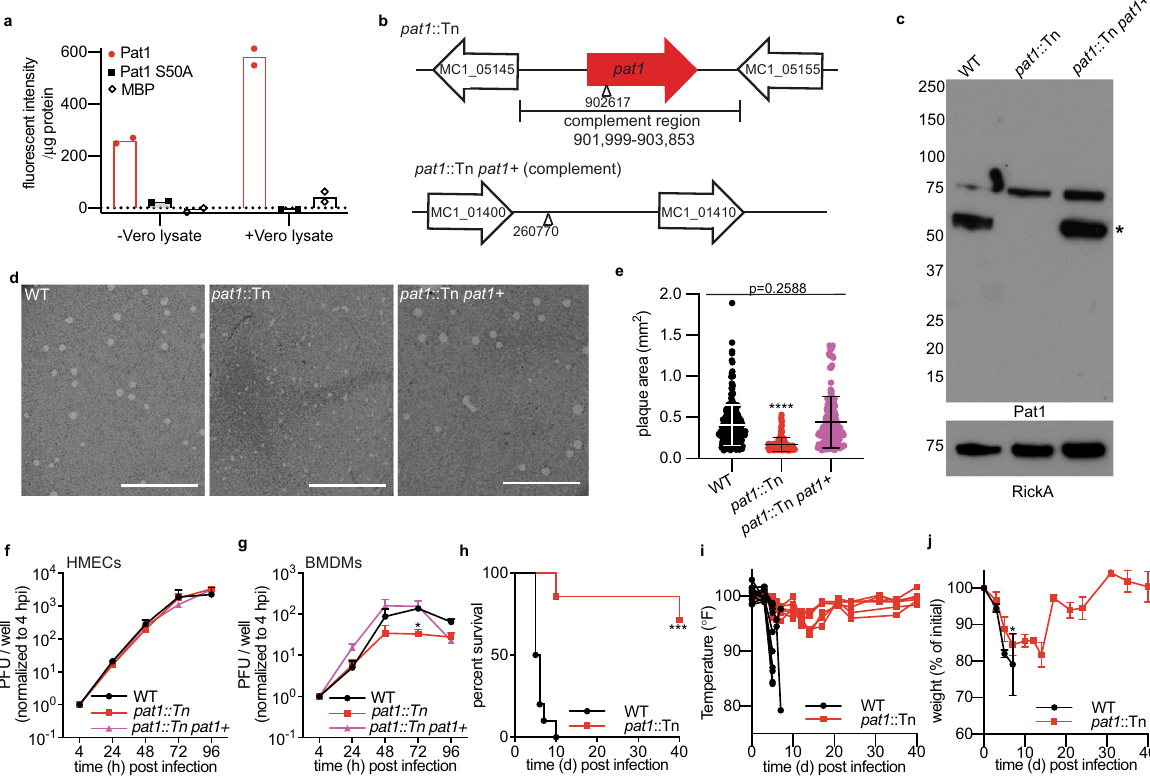
Fig. 1 Pat1 is a PLA 2 enzyme important for infection of cells and in mice. a Graph of fl uorescence emissions intensity of fl uorogenic PLA 2 substrate Red/ Green BODIPY PC-A2 at 535 nm after a 2 h incubation with the indicated protein. Bar represents mean from n = 2 independent experiments, each with three technical replicates. b Genomic loci of pat1 (top) and pat1 insertion site for complementation (bottom). Triangle represents transposon insertion sites, and nucleotide numbers indicate the position in the R. parkeri genome. Genes upstream and downstream are included to show intergenic regions. c Western blot of puri fi ed R. parkeri strains, WT, pat1 ::Tn, and complemented strain ( pat1 ::Tn pat1 + ), probed with anti-Pat1 antibody; anti-RickA was used as a loading control. Pat1 has a predicted size of 55kD (asterisk, beneath a higher molecular weight background band that is observed in all samples). The image represents results from three independent experiments. The numbers on left are molecular weight in kD. d Images of plaques stained with neutral red at 6 dpi (WT and pat1 ::Tn pat1 + ) and 8 dpi ( pat1 ::Tn). Scale bar 10 mm. Represents results from two independent experiments. e Plaque areas in Vero cells infected with WT (7 dpi), pat1 ::Tn (8 dpi), and complemented strain (7 dpi) ( n = 2 independent experiments; WT n = 263 plaques, pat1 ::Tn n = 109 plaques, pat1 ::Tn pat1 + n = 141 plaques). Data are mean ± SD; **** p < 0.0001 relative to WT (one-way ANOVA with Dunnett ’ s post hoc test). f Bacterial abundance of WT, pat1 ::Tn, and complemented strain in ( f ) HMECs ( n = 3 independent experiments), MOI 0.01 and ( g ) BMDMs (n = 3 independent experiments), MOI 0.5. Data in ( f , g ) are mean ± SEM; p -values were signi fi cantly different in ( g ) at 72 hpi (WT vs pat1 ::Tn p = 0.0154, WT vs pat1 ::Tn pat1 + p = 0.6871, pat1 ::Tn vs pat1 ::Tn pat1 ::Tn p = 0.3479) (two-way ANOVA with Tukey ’ s post hoc test). h Survival of Ifnar1 − / − ; Ifngr1 − / − mice infected